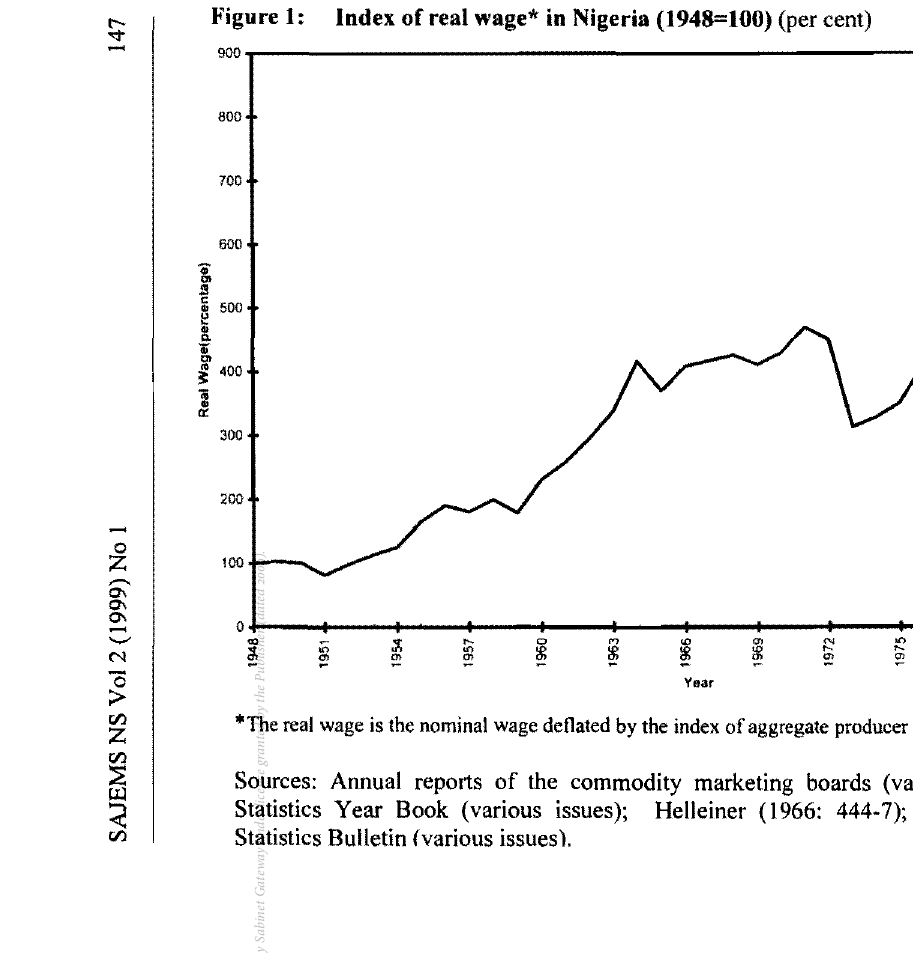
Figure 1: Index of real wage* in Nigeria (1948=100) (per